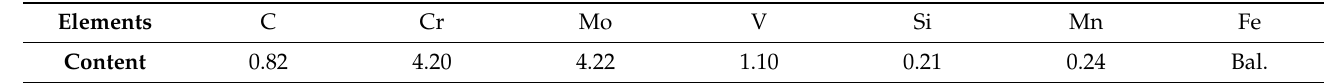
Table 1. Chemical composition of M50 steel (mass fraction,